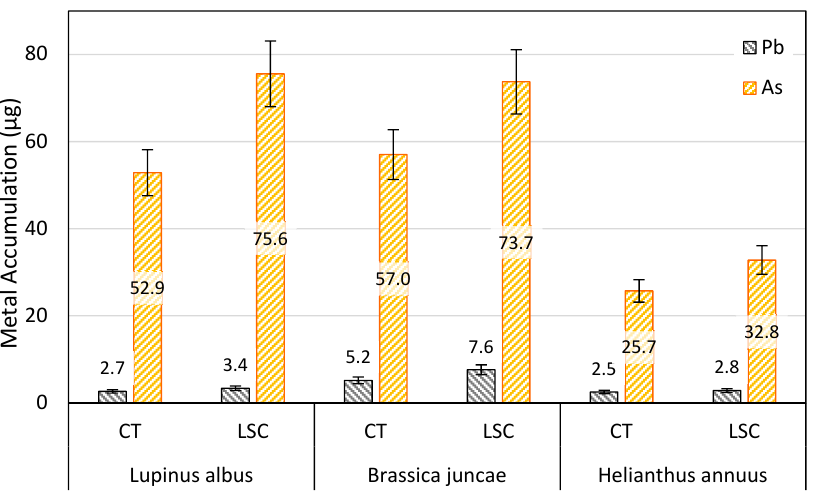
Figure 8. Total accumulation of As and Pb in the aerial part of plants grown under and outside the red panel. Values are reported as mean ± standard deviation.